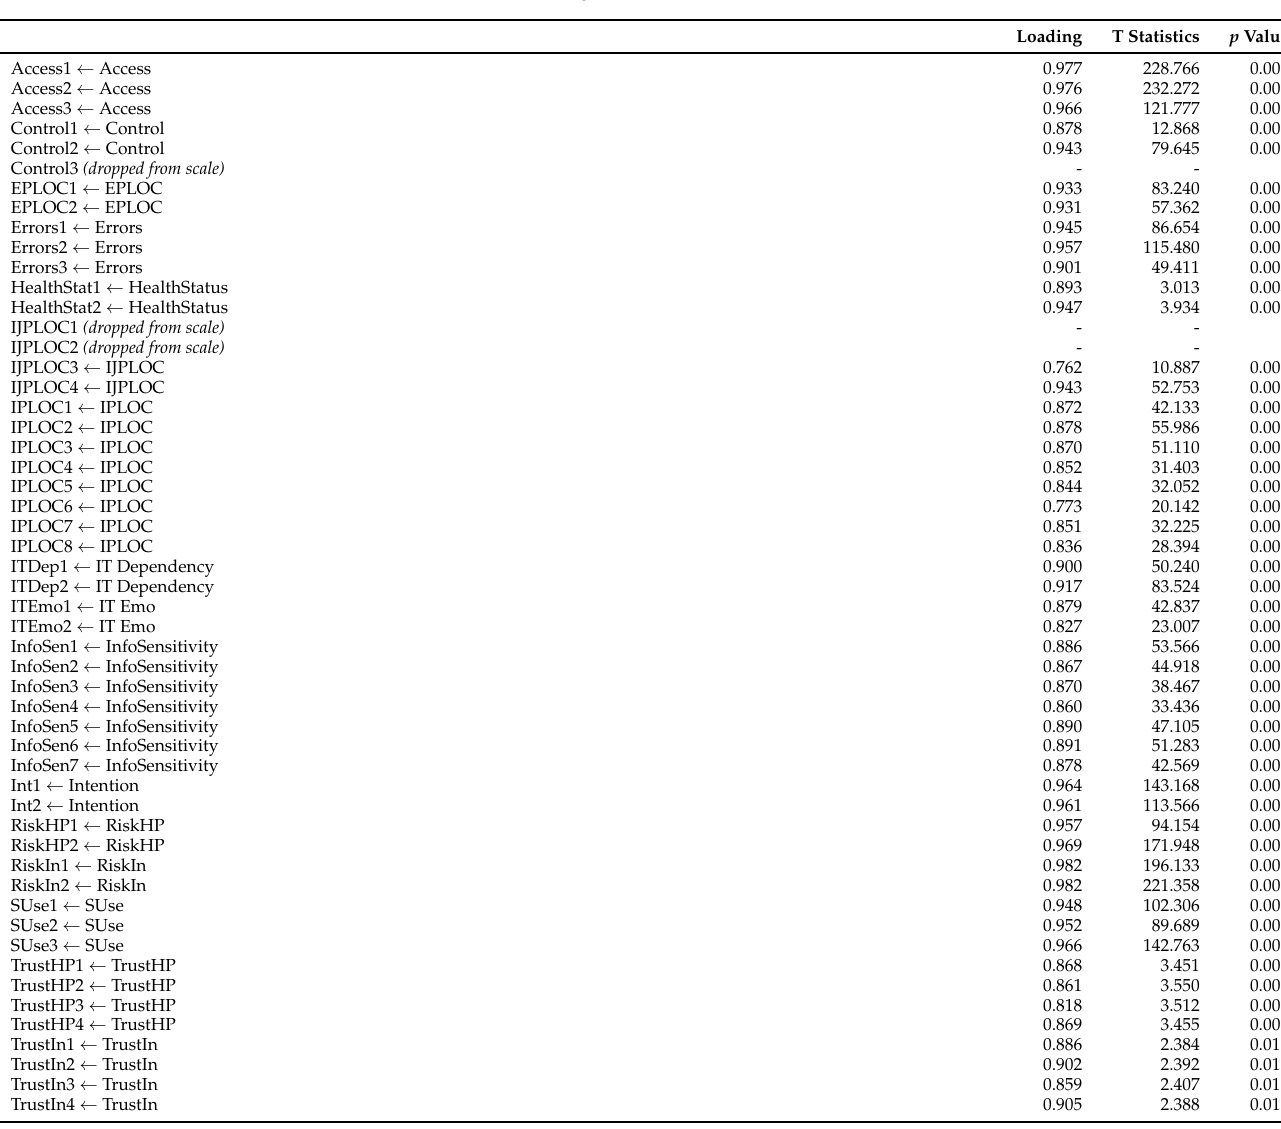
Table A8. Loadings of the Multi-Item